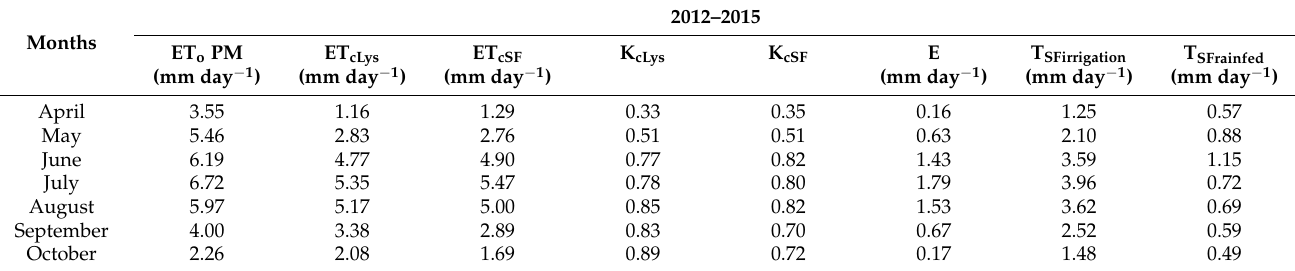
Table 3. Average of the four years of study of the mean daily values for each month of reference evapotranspiration (ET o PM), crop evapotranspiration obtained in the lysimeter (ET cLys ), crop evapotranspiration obtained with the sap flow sensors (ET cSF ) in the irrigation treatment, crop coefficient obtained from the lysimeter (K cLys ), crop coefficient obtained as T SF + E (K cSF ), evaporation (E), transpiration obtained with the sap flow sensors in the irrigation treatment (T SFirrigation ) and transpiration obtained with the sap flow sensors in the rainfed treatment (T SFrainfed ).